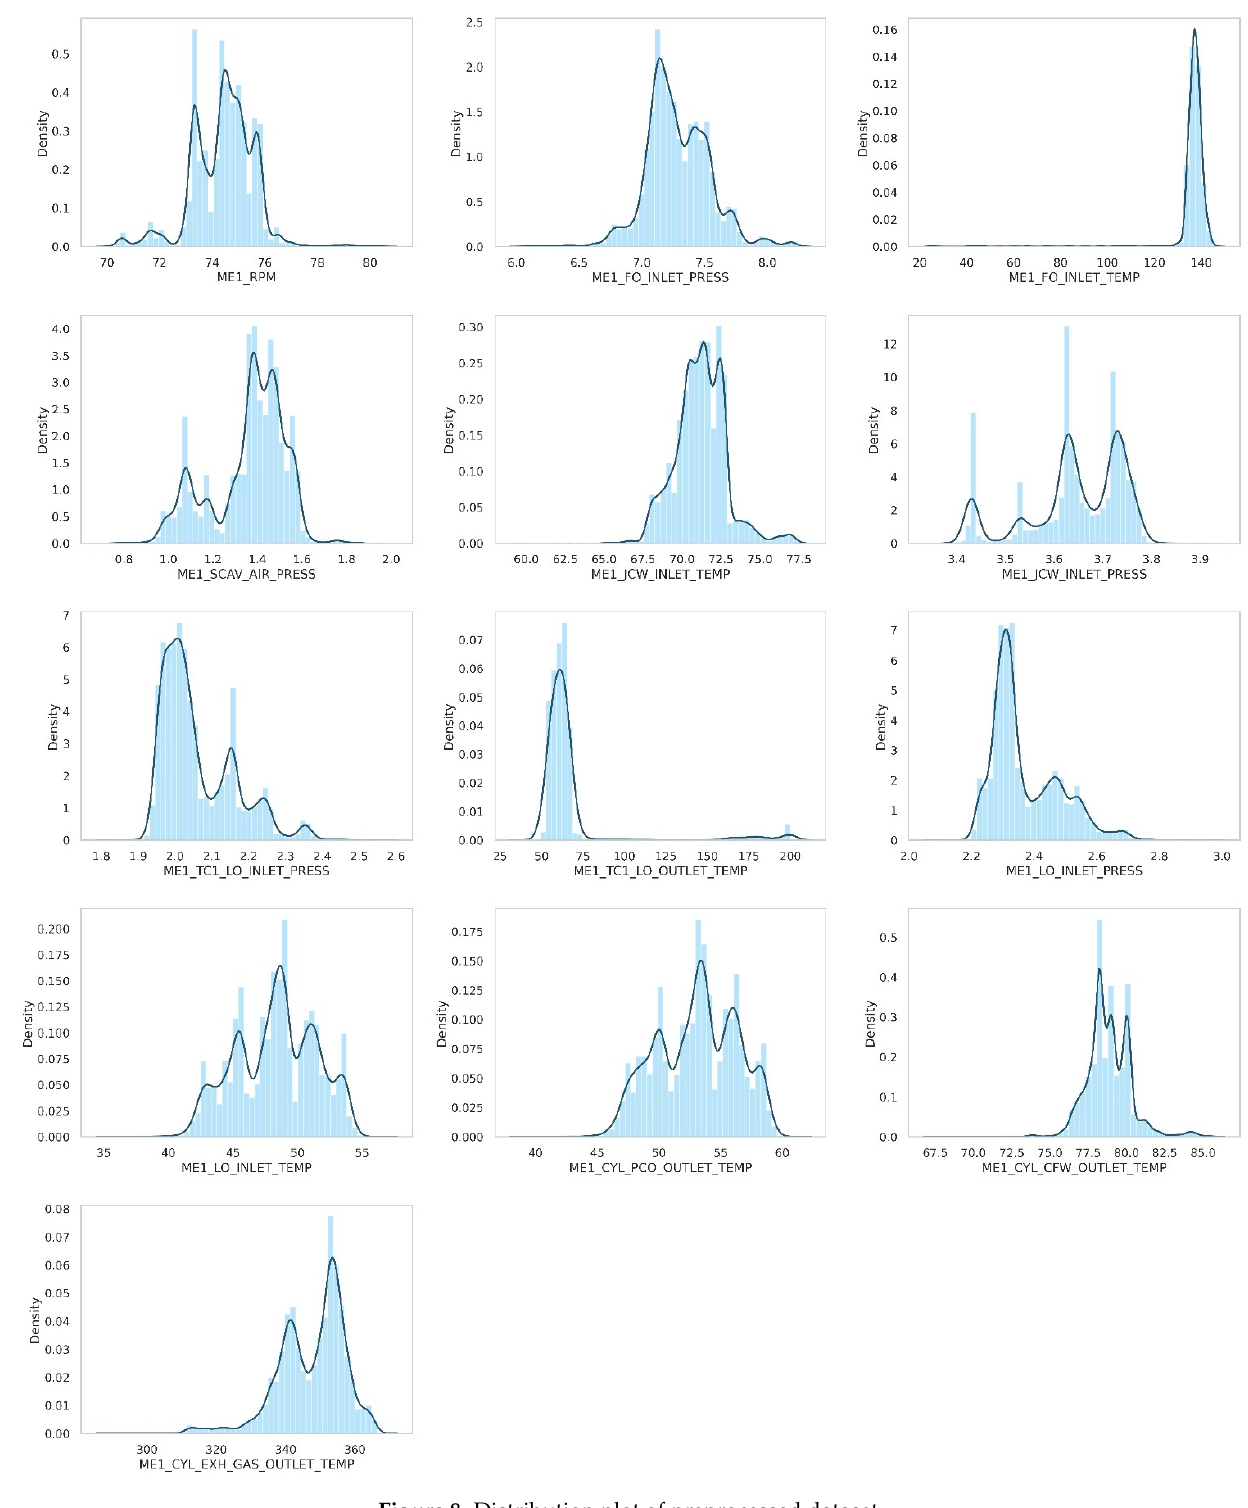
Figure 8. Distribution plot of preprocessed dataset.